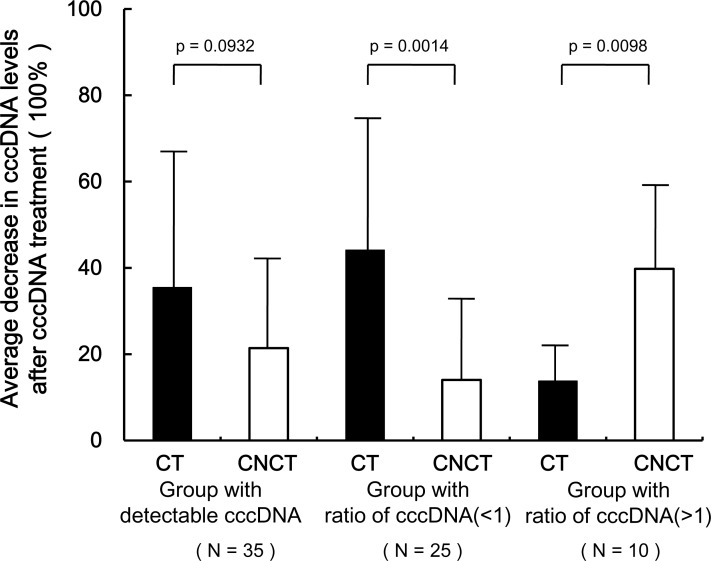
Effect of APE1 treatment on detection of cccDNA levels in 35 paired CT and CNCT samples.The 35 paired HCC samples with detectable cccDNA values (left column, N = 35) were divided into two group according to ratio of cccDNA in the paired CT and CNCT samples (CT/CNCT) < 1 (middle column, N = 25) or >1 (right column, N = 10). Extracted tissue DNAs containing the cccDNA were treated with APE1, and cccDNA levels were measured before and after treatment. The decrease in cccDNA levels in each sample was calculated as = (value before APE1 treatment—value after APE1 treatment) / value before APE1 treatment. CT: cancerous tissues, CNCT: Contiguous noncancerous tissues.